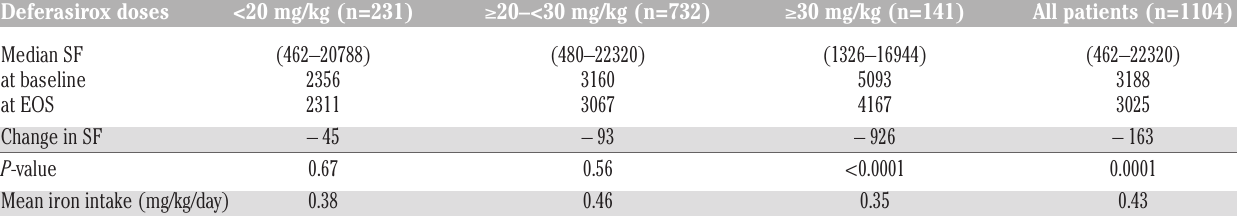
Table 4. Change in serum ferritin from baseline by mean accrual dose of DFX (Data from Cappellini MD, et al. Haematologica 2010; 95(4); 557–66). Deferasirox doses